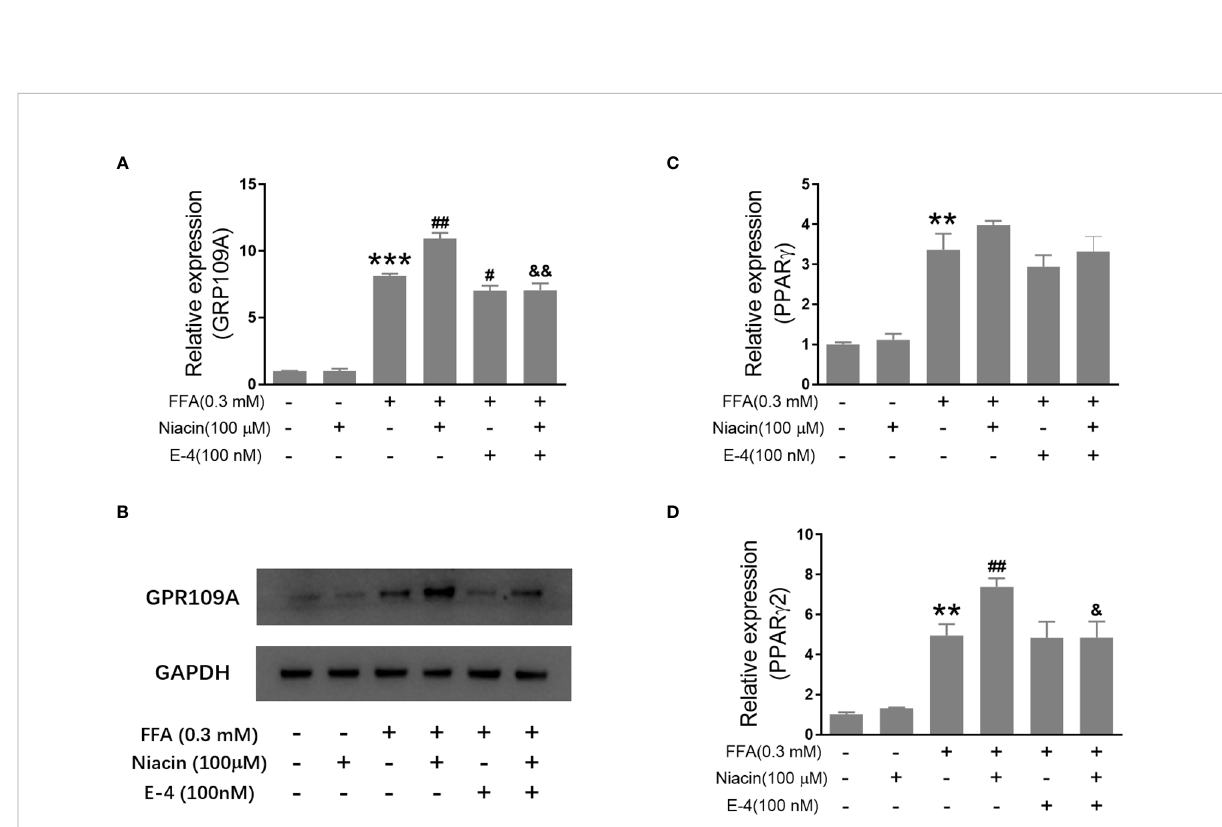
FIGURE 4 Niacin up regulates the expression of GPR109A and PPAR g 2 in the presence of FFA and was inhibited by exendin-4. INS-1 cells were treated with niacin, exendin-4 or niacin plus exendin-4 in the absence or presence of FFA for 48 hours. (A, C, D) Total RNA was extracted for quantitative PCR. (B) Total protein was extracted for western blot analyse. Data were from three independent experiments and represent mean ± SD. n=3, **P < 0.01 and ***P < 0.001 compared to the control group; # P < 0.05 and ## P < 0.01 compared to the FFA group; & < 0.05 and && < 0.01 compared to the FFA +niacin